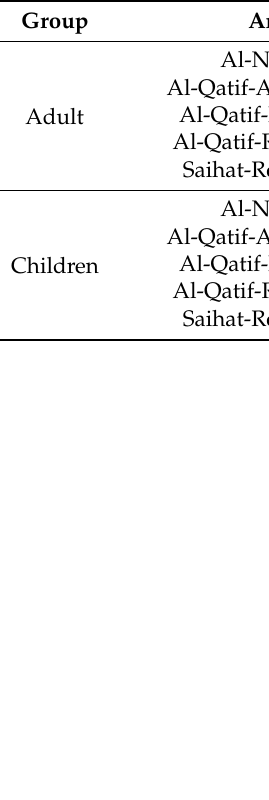
Table 5. Cancer risk from ingestion of Pb, Cd, and Cr in AC filters from different sampling